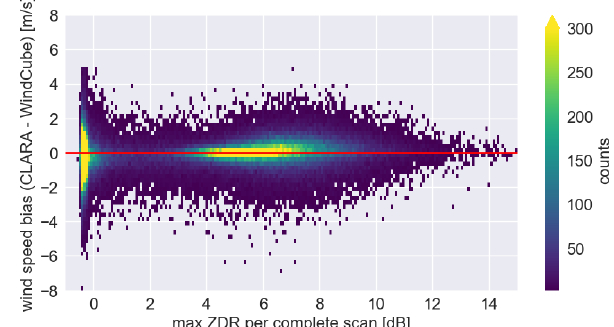
Figure 7. Two-dimensional histograms of the difference between WindCube’s and CLARA’s wind speed from the lowest 2km as a function of the maximum ZDR. Note that only data with I inv smaller than 50% are